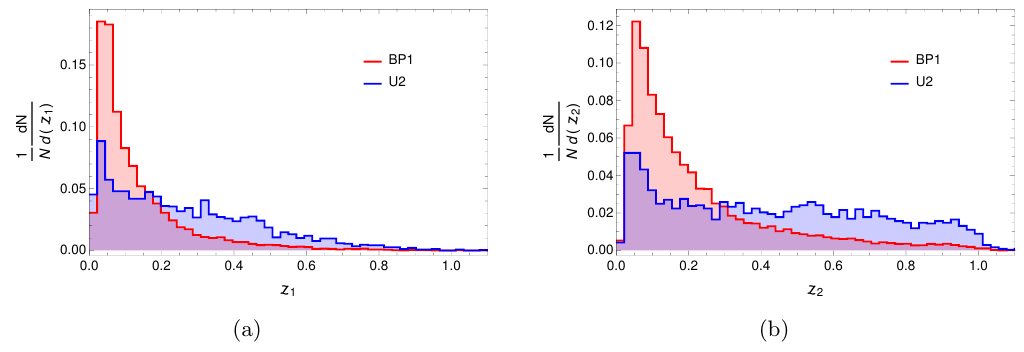
Figure 8 . Normalized distributions of new kinematic variable compressed and uncompressed